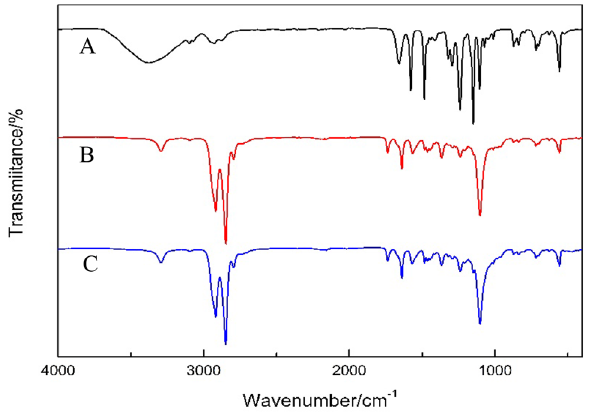
Figure 3. FTIR spectra A (supporting membrane), B (composite membrane) and C (modified membrane).